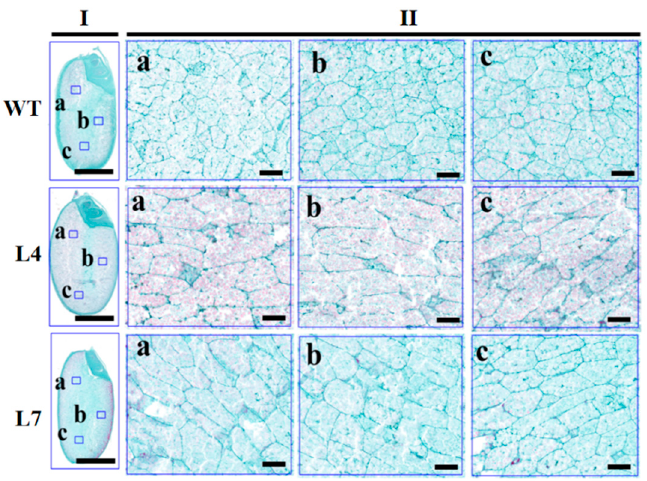
Figure 7. Paraffin sections of the endosperm of WT and transgenic rice seeds. ( a – c ) The endosperm cells in different sections. Scare bars: 2 mm in I, 50 µm in II.